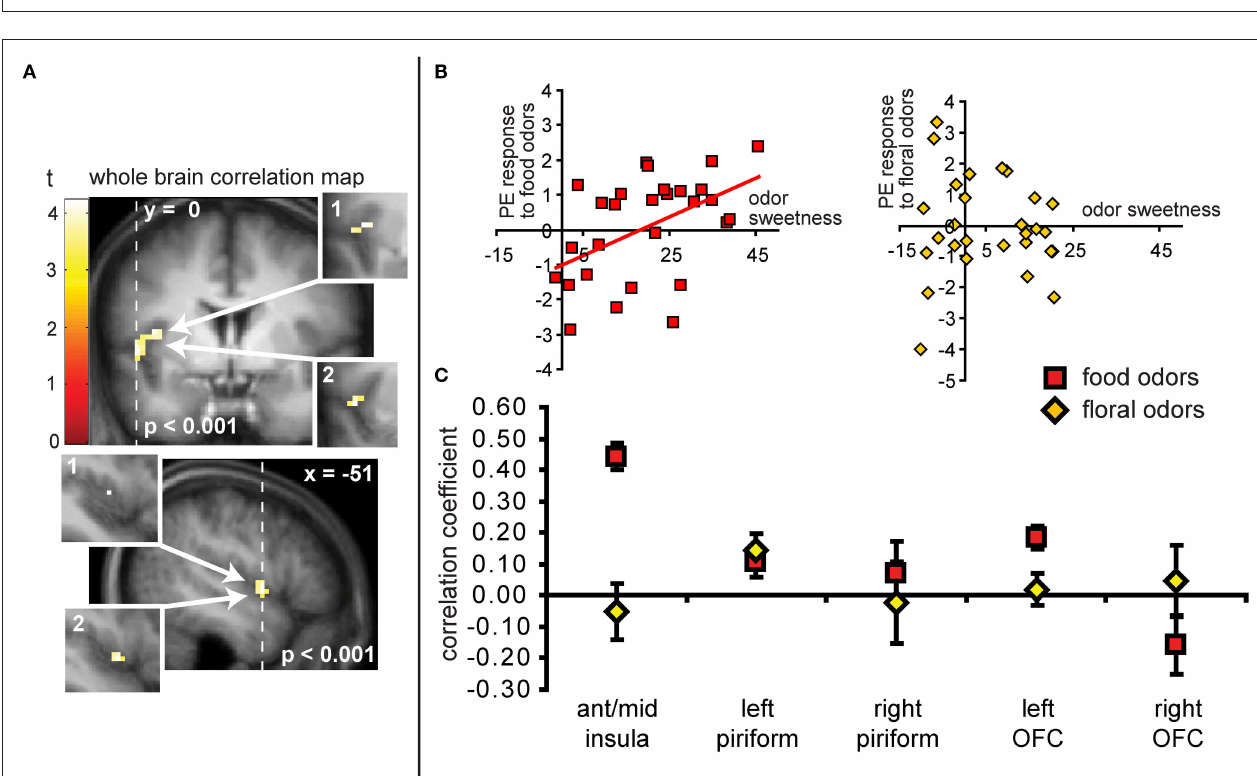
(dark green) and the weak sweet taste (light green) ( ± s.e.m.), averaged over subjects. The response was taken from the voxel that responded maximally, as identified in the SPM analysis. Thus, these estimates are non- independent, and are provided to illustrate the relative difference in neural response.